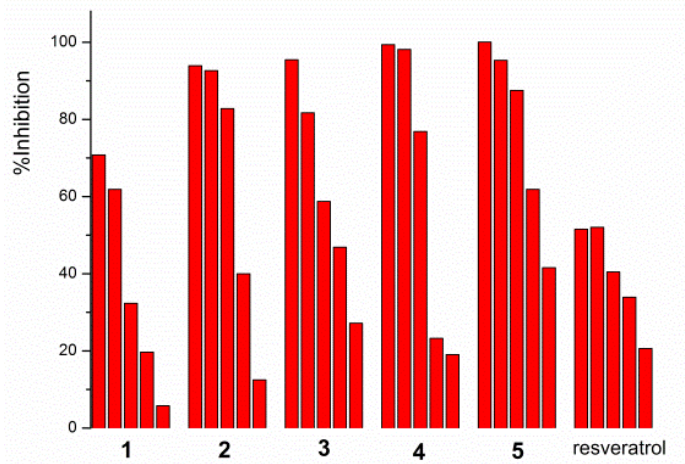
Figure 4. Concentration-dependent α -glucosidase inhibition of compounds 1 – 5 and resveratrol (concentration from high to low, 1 and 2 : 0.020, 0.018, 0.015, 0.010, 0.005 mM; 3 and 4 : 0.015, 0.010, 0.0050, 0.0015, 0.0010 mM; 5 : 0.08, 0.050, 0.030, 0.020, 0.018 mM; resveratrol: 0.050, 0.030, 0.020, 0.016, 0.010